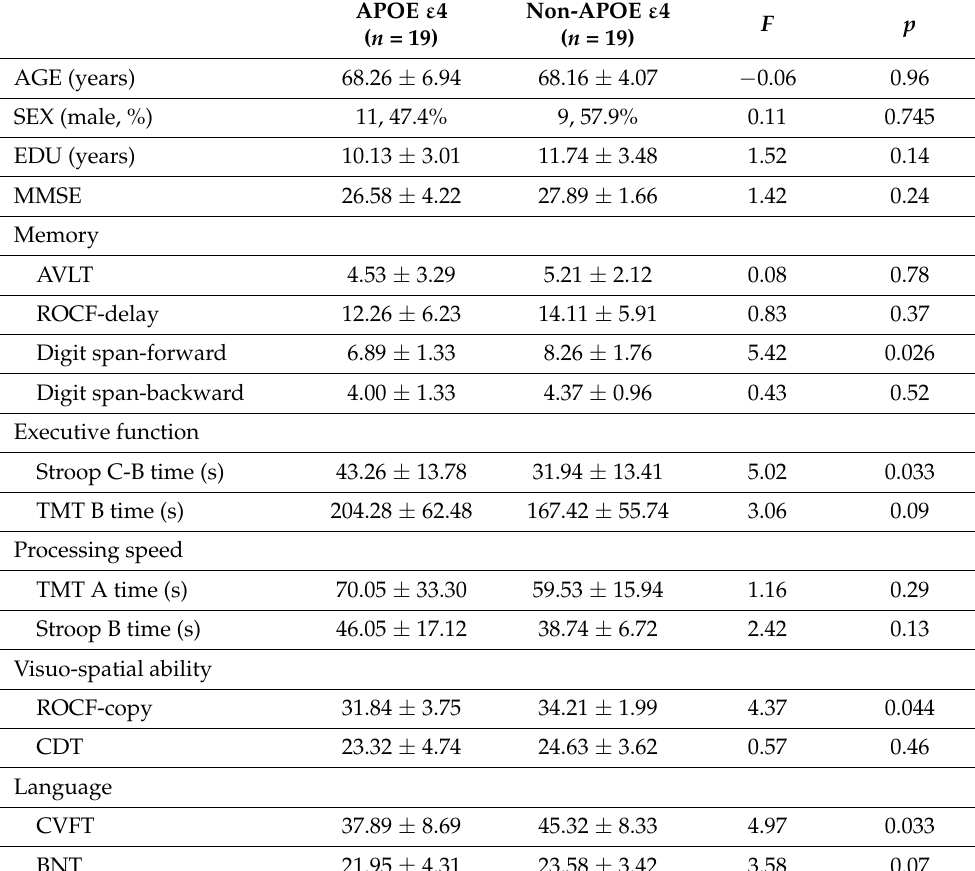
Table 2. Characteristics and neuropsychologic test results of participants in MRI sample.